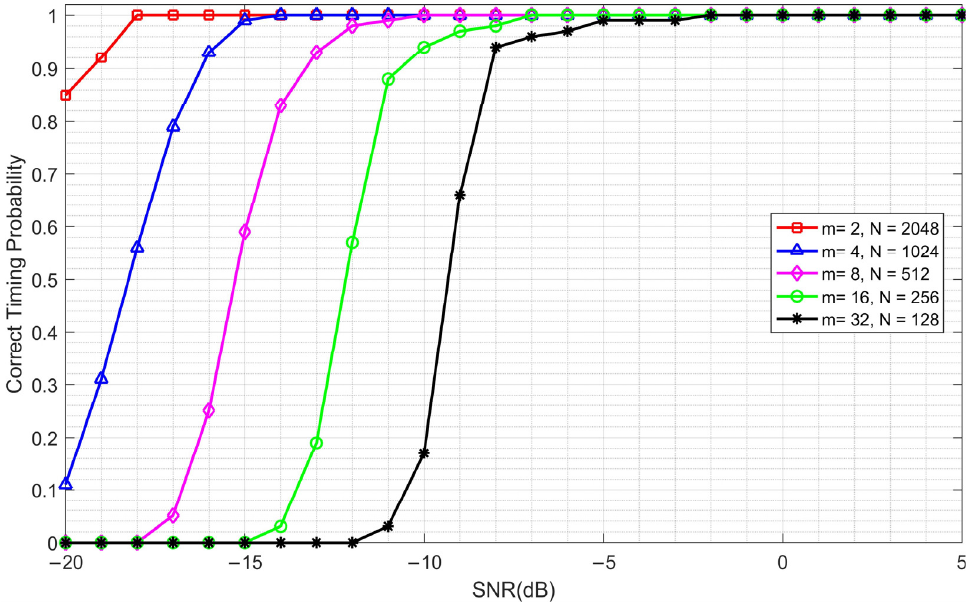
Figure 10. The correct timing probability of the CCPD algorithm with different m and N under a fi xed CFO of 4 kHz.